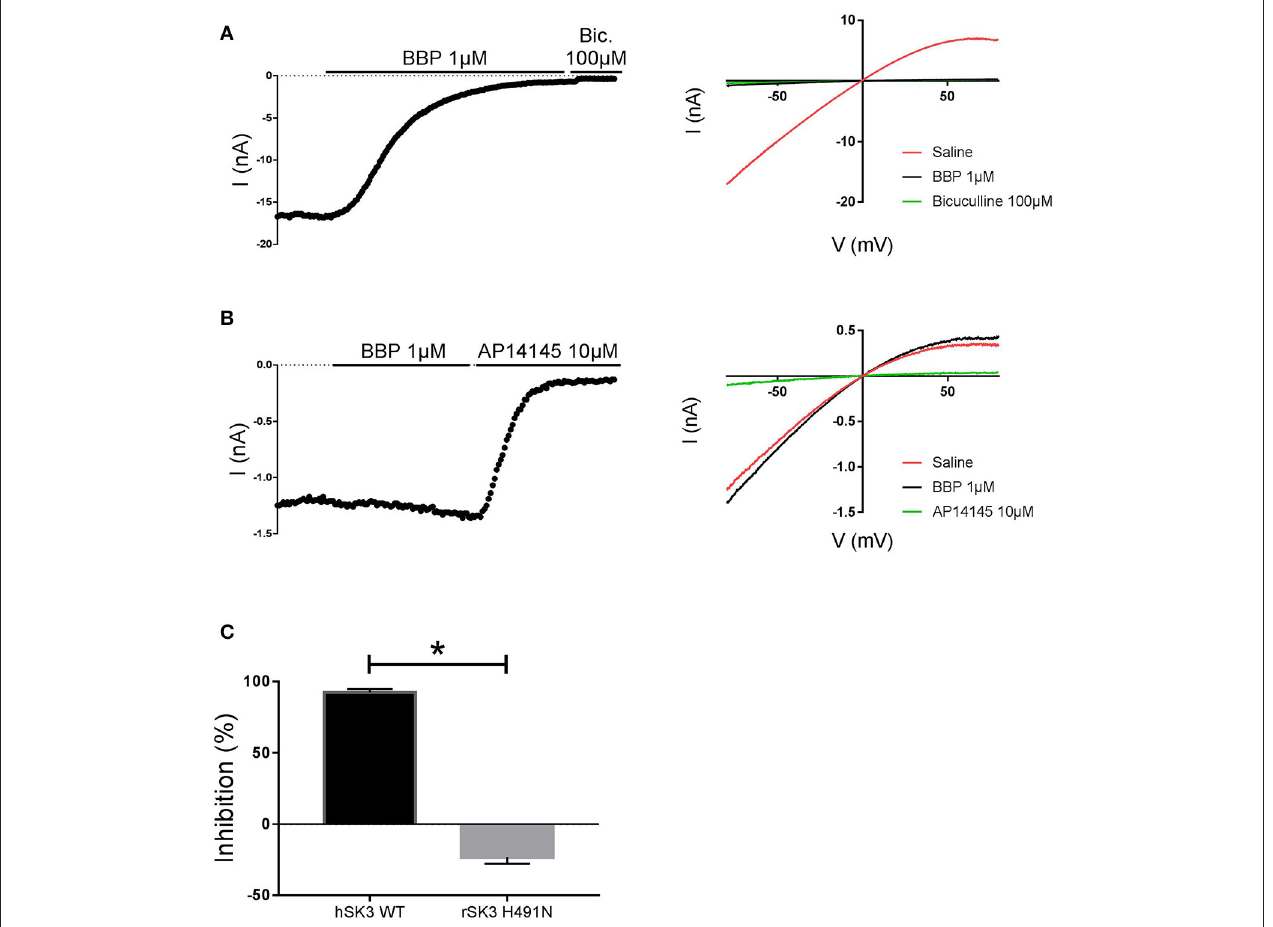
FIGURE 7 | Effect of BBP 1 µ M on hSK3 WT ( n = 5) and rSK3 H491N ( n = 8). Representative current-time plots (left) and their corresponding current-voltage plots (right) depicting the effect of BBP 1 µ M on hSK3 WT (A) and rSK3 H491N (B) . The results are summarized in the column graph (C) comparing the effect of the compound on both the WT and mutant channel. The mutant rSK3 H491N channel was insensitive to the inhibitory effect of BBP compared to the WT channel. * p <